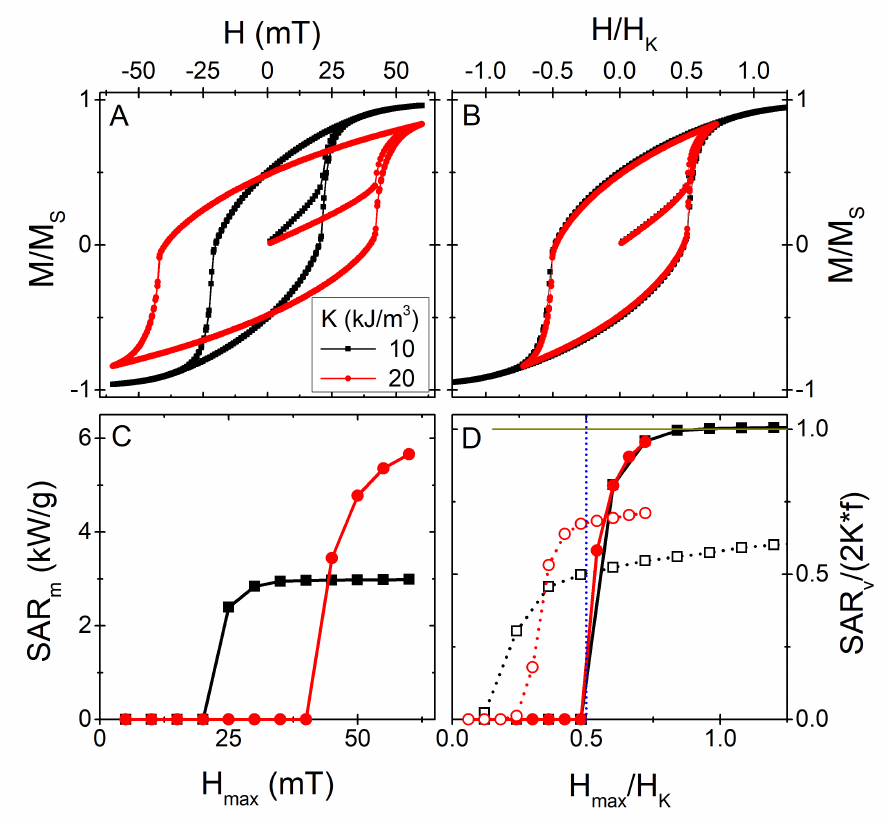
Figure 3. ( A ): Illustrative M vs. H hysteresis loops of two systems of particles of the same size ( d = 20 nm) and M S = 480 kA/m, but different K (10 and 20 kJ/m 3 , respectively), at T = 0 K and for H max = 25 mT. ( B ): Same data as in ( A ), replotted in terms of H / H K . ( C ): SAR vs. H max for the two different particles, for f = 765 kHz, at T = 0 K. ( D ): Same data as in panel ( C ), replotted in terms of SAR /2 K ∗ f and H / H K ; the curves with open symbols correspond to the T = 300 K case. The vertical blue dotted line stands for the ∼ 0.5 H K threshold of the random distribution [39], and the horizontal solid dark-yellow line indicates the normalized maximum SAR / ( 2 K ∗ f ) = 1 limit